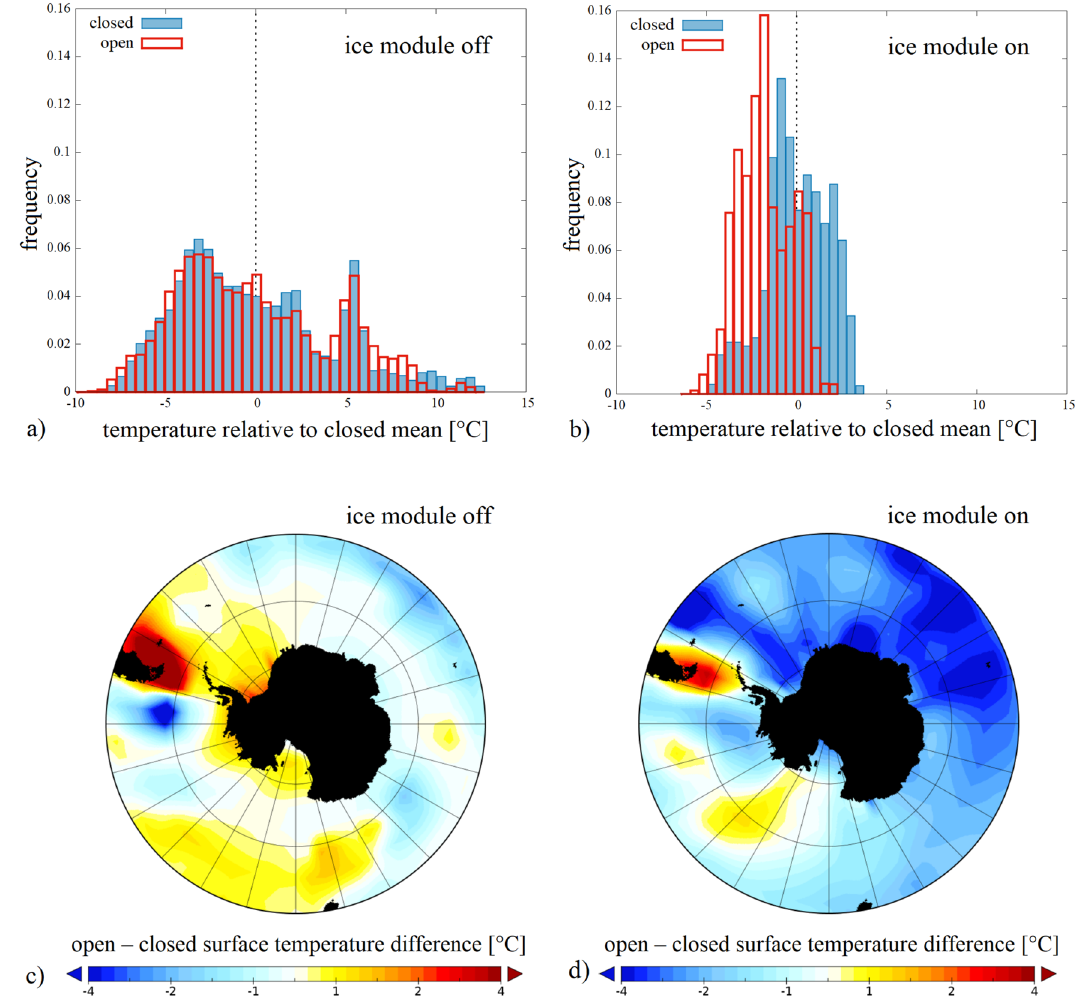
Figure 6. Surface temperature anomalies in the GCM. a, b, Histograms of the sea surface temperature anomaly field of the domain of the Southern Ocean (between latitude 55 ◦ S and the Antarctic circle) acquired from the annually averaged temperature fields of 200 subsequent years in both the “closed” (blue) and the “open” (red) configurations. The anomalies here are given as the deviation from the mean of the “closed” distributions (hence both “closed” histograms are exactly zero-centered). Panels ( a ) and ( b ) correspond to the inactive and active sea ice dynamics presets, respectively. ( c , d ) Temporally averaged maps of sea surface temperature change, i.e. the difference between temporal mean temperatures of the two barrier configurations � T open � − � T closed � corresponding to the inactive ( c ) and active ( d ) sea ice dynamics presets. Panels ( a ) and ( b ) were created using Gnuplot version 5.2, Release 5.2.8 (freely available and downloadable at http:// www. gnupl ot. info/), panels ( c ) and ( d ) were created using Panoply 4 developed at the NASA Goddard Institute for Space Studies (freely available and downloadable at https:// www. giss. nasa. gov/ tools/ panop 200-year-long series of quasi-stationary data. The blue and red graphs represent the distributions from the “closed” and the “open” configurations, respectively. The temperature scale was adjusted so that the mean of the “closed” record is subtracted from all measured values, thus the “closed” histograms are centered to zero in both panels. In panel (a) the GCM’s ice module was turned off, whereas in panel (b) it was active. The most striking feature of the simulations with inactive ice module (Fig. 6a) is that the histograms remain practically identi- cal in the “open” and “closed” cases. However, when the ice module is active in the model (Fig. 6b), the “open” configuration yields markedly lower surface temperatures in the Southern Ocean, in qualitative agreement with the EOT paleotemperature records. The spatial patterns associated with the (imaginary) opening event’s impact on the time-averaged surface temperatures of the Southern Ocean and Antarctica are demonstrated in the maps of Figs. 6c and d. The differ- ence between the average values from the “open” and “closed” configuration � T open � − � T closed � is plotted in both settings of the sea ice module. In the absence of sea ice dynamics (panel c) the domain up to ca. 70 ◦ S exhibits markedly higher temperatures in the “open” configuration than in the “closed” one. In the fully ocean-covered latitudes (North of the 70 ◦ S circle) the difference between the “open” and “closed” cases is negligible in terms of zonal means (cf. Fig. 6a). Averaging over the investigated domain (or the entire globe), therefore a slight